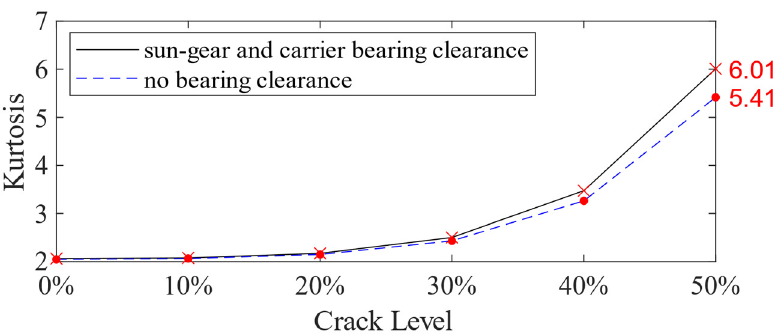
Figure 21. Kurtosis of the vibration signal for the planetary gearbox with 0%, 10%, 20%, 30%, 40% and 50% crack